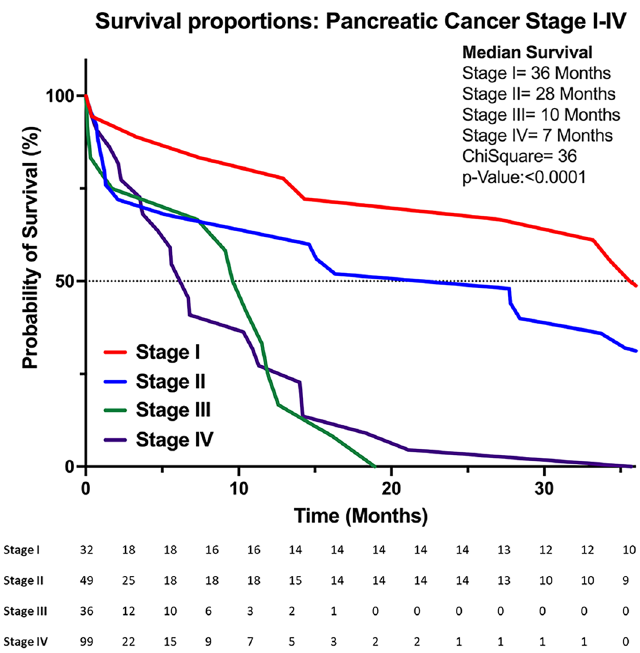
Figure 1. Survival rates by